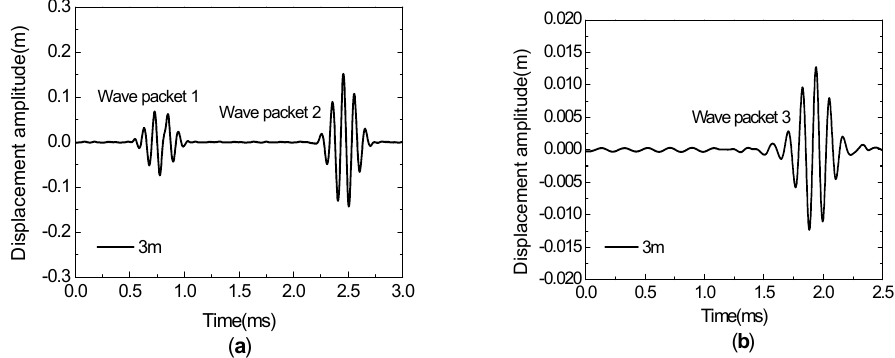
Figure 7. Time-domain waveform of radial displacement with respect to time ( β = 0.1) ( a ) at the liquid–pipe interface in infinite porous medium and ( b ) at the external interface of the finite porous medium. The thickness of the finite porous medium is d = 0.05 m. The vertical and horizontal axes depict the displacement amplitude and time.